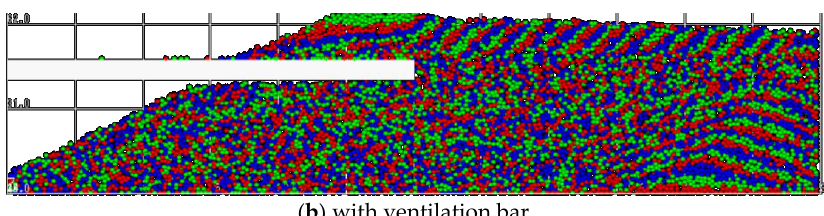
Figure 4. Packing structures of sinter bed ( a ) without and ( b ) with ventilation bar. The particles were continuously generated on the chute and periodically colored red, green, and blue. Energies 2020 , 13 , x FOR PEER REVIEW